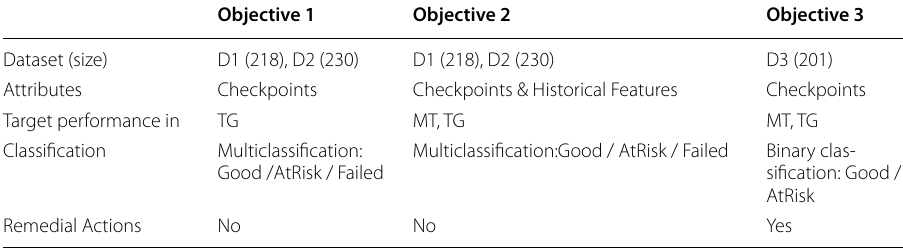
Table 3 Summary of research